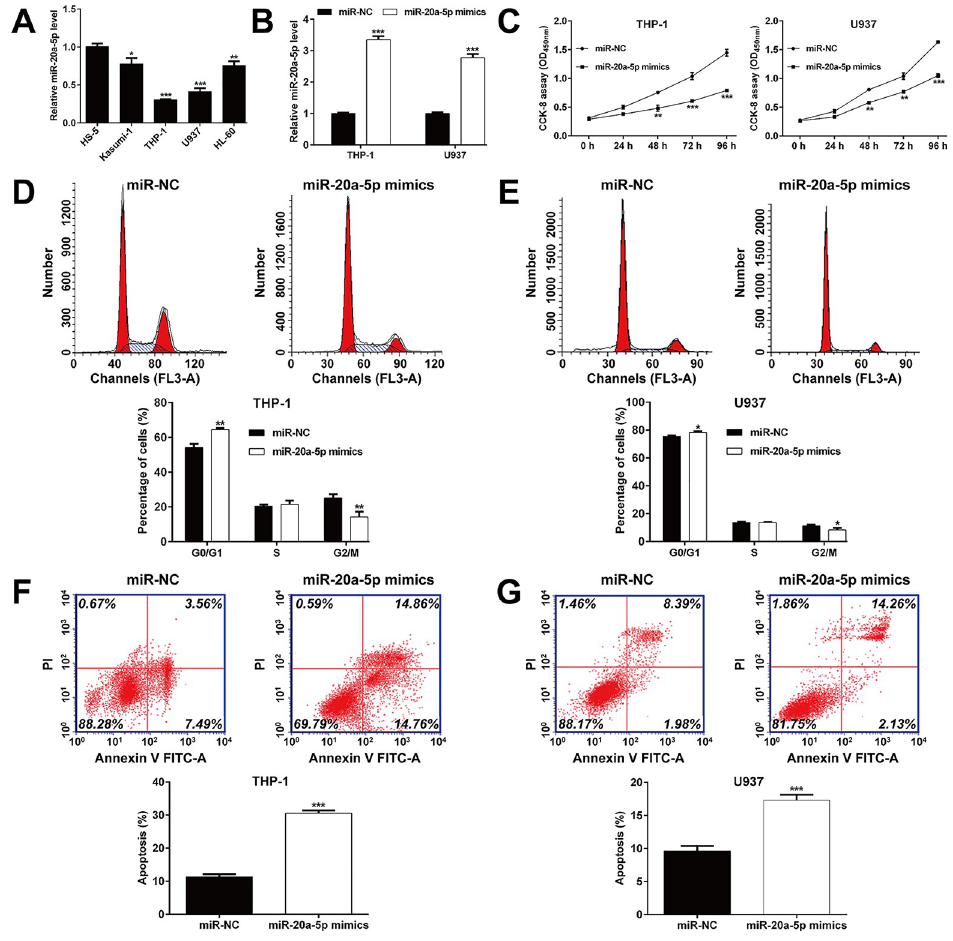
Fig 2. Effects of miR-20a-5p overexpression on cell proliferation, cell cycle progression and apoptosis in AML cells. (A) Expression of miR-20a-5p in four AML cell lines (Kasumi-1, THP-1, U937 and HL-60) and a normal human bone marrow stromal cell line HS-5 were detected by quantitative real time PCR analysis. (B) Expression of miR-20a- 5p was determined in THP-1 and U937 cells after transfection with miR-20a-5p mimics or miR-NC. (C) CCK-8 assay was performed to assess the proliferation of transfected THP-1 and U937 cells. (D-E) The percentage of cells at G0/G1, S and G2/M phase was analyzed by flow cytometry in transfected THP-1 and U937 cells. (F-G) Apoptotic cells were quantified in transfected THP-1 and U937 cells by flow cytometry analysis. Data are presented as mean ± SD of three independent experiments. � p < 0.05, �� p < 0.01, ��� p < 0.001, compared with